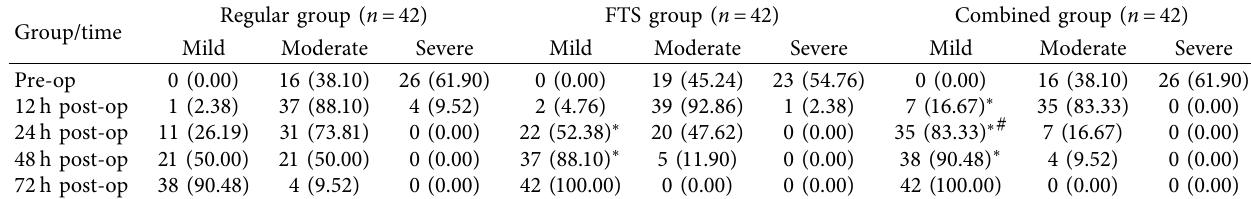
Table 1: Comparison of pain levels among the three groups at different times ( n , %).